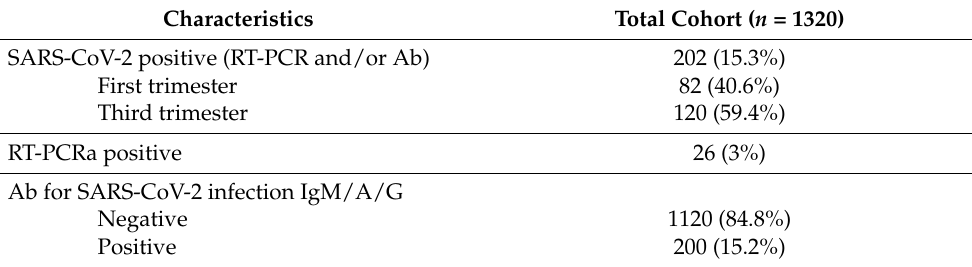
Table A3. Prevalence of SARS-CoV-2 infection during